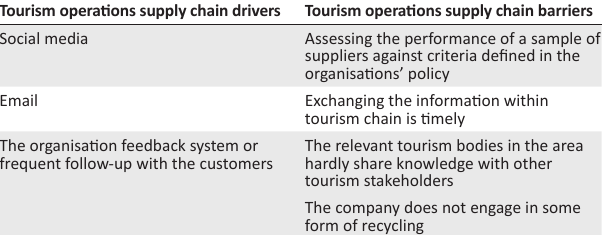
TABLE 2: Tourism operations supply chain drivers and barriers in Tshwane. Tourism operations supply chain drivers Tourism operations supply chain